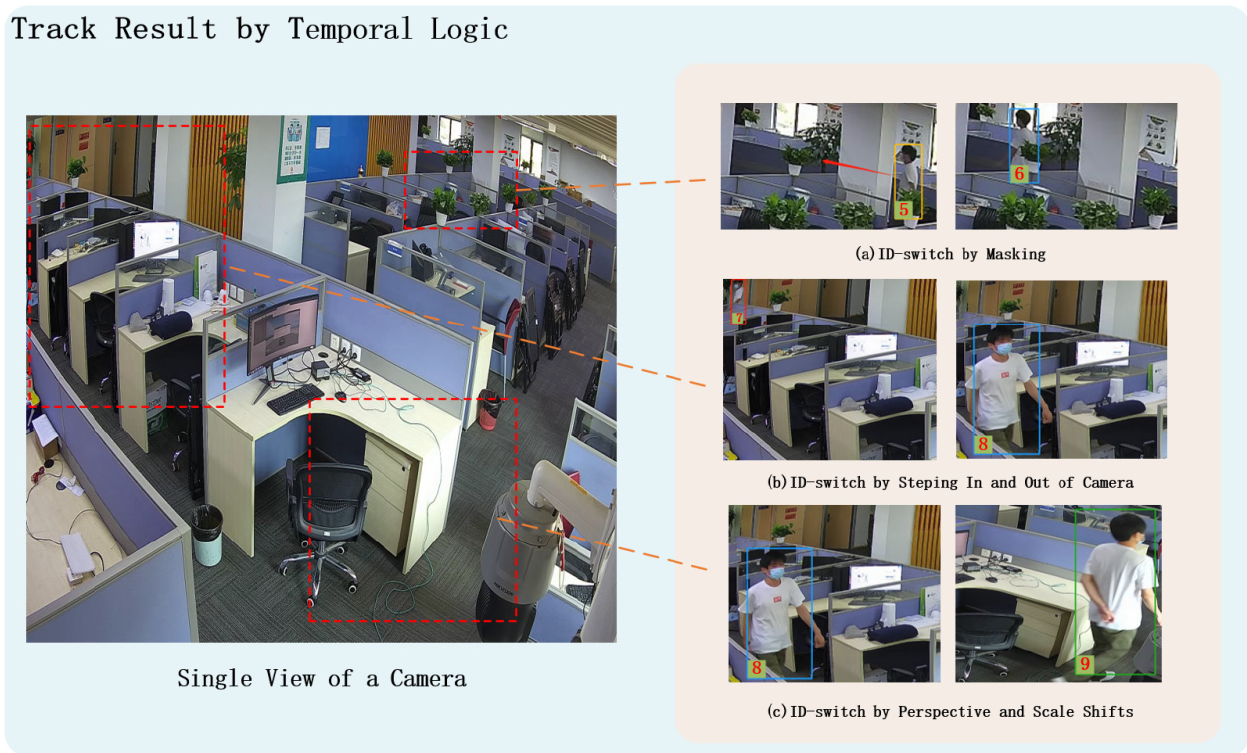
Figure 12. Graph of continuous tracking results based on the transformer’s temporal logic.